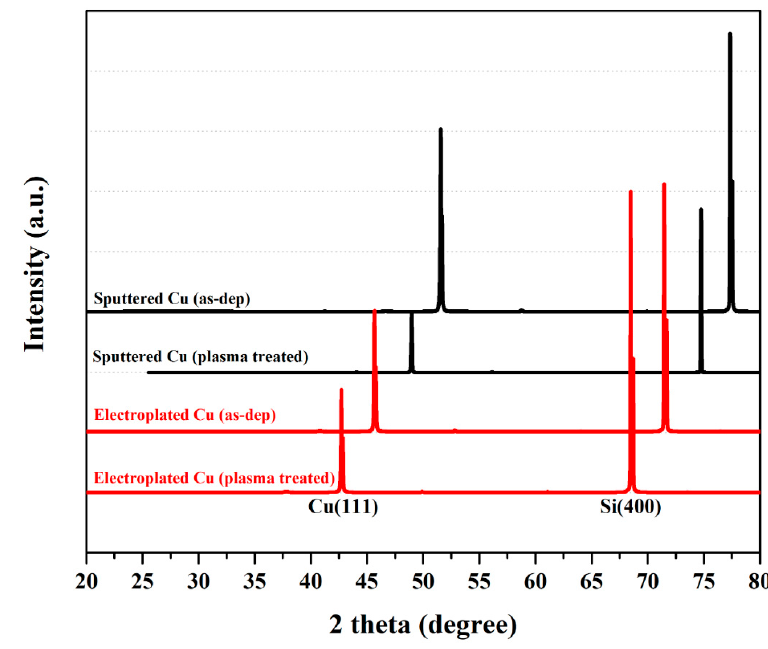
Figure 3. XRD analysis of sputtered and electroplated Cu thin films.